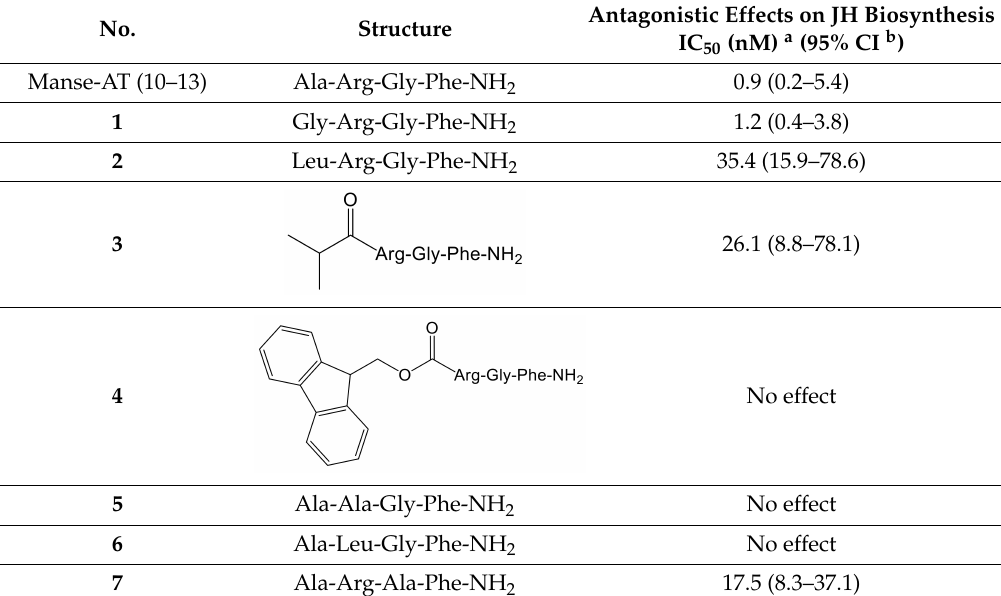
Table 2. Structures and antagonistic effects on JH biosynthesis of Manse-AT